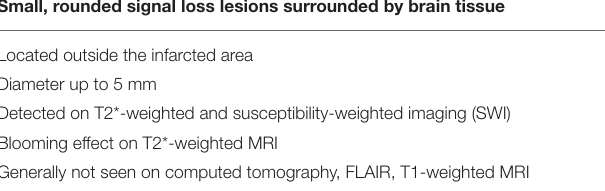
TABLE 2 | Cerebral microbleeds (CMBs)—neuroimaging characteristics. Small, rounded signal loss lesions surrounded by brain tissue Located outside the infarcted area Diameter up to 5